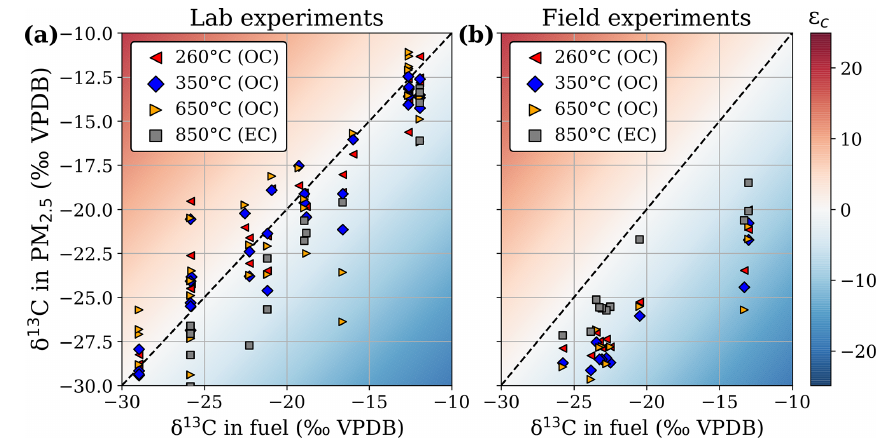
Figure 5. The δ 13 C measured in the different volatility fractions of the captured PM 2 . 5 versus δ 13 C in the fuel for lab experiments (a) and samples from landscape fires in Mozambique (b) . The temperature classes refer to the evaporation temperature steps in the oven of the organic carbon (OC)–elemental carbon (EC) analyser.